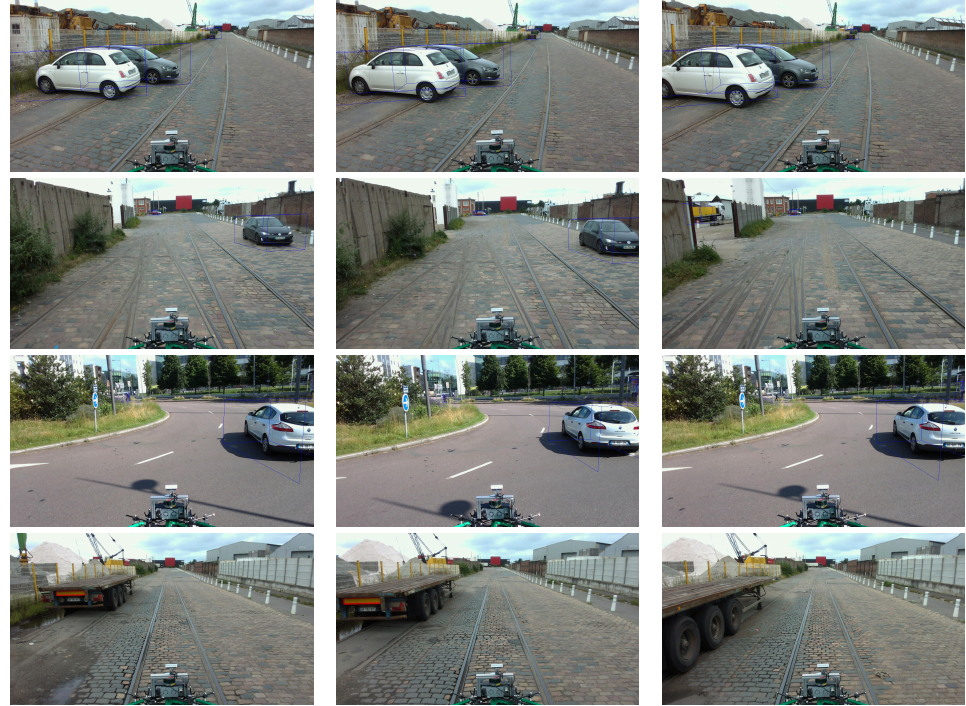
Figure 16. Examples of image annotations and predictions in the ESRORAD dataset. Results obtained through our lightweight 3D object detection algorithm [24] and trained for 300 epochs on the Nuscenes [40]